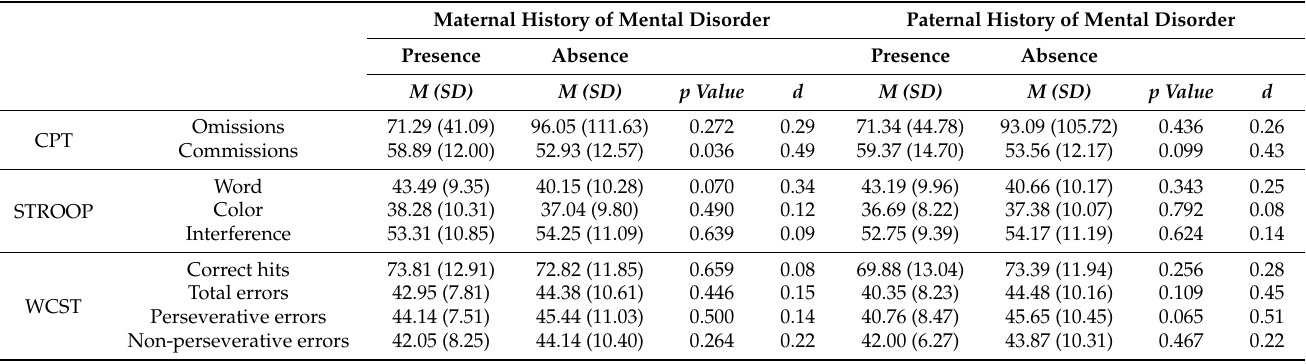
Table 3. Relationship between maternal and paternal history of mental disorder and cognition.